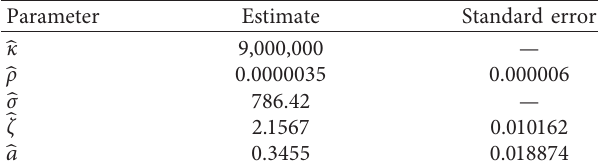
Table 5: Maximum likelihood estimates.